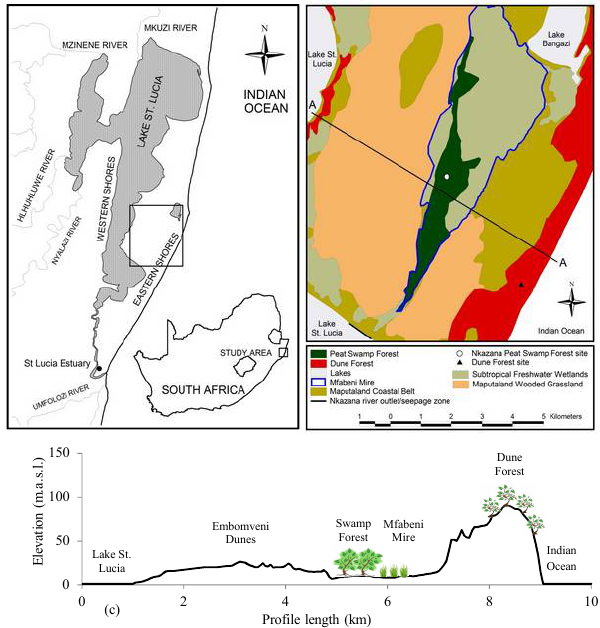
Fig. 1. (a) Location of Lake St. Lucia and research area in South Africa, (b) the Nkazana peat swamp forest site and the Dune Forest site with the distribution of the vegetation on the Eastern Shores and (c) a cross-sectional profile of transect A–A in Fig. 1b.